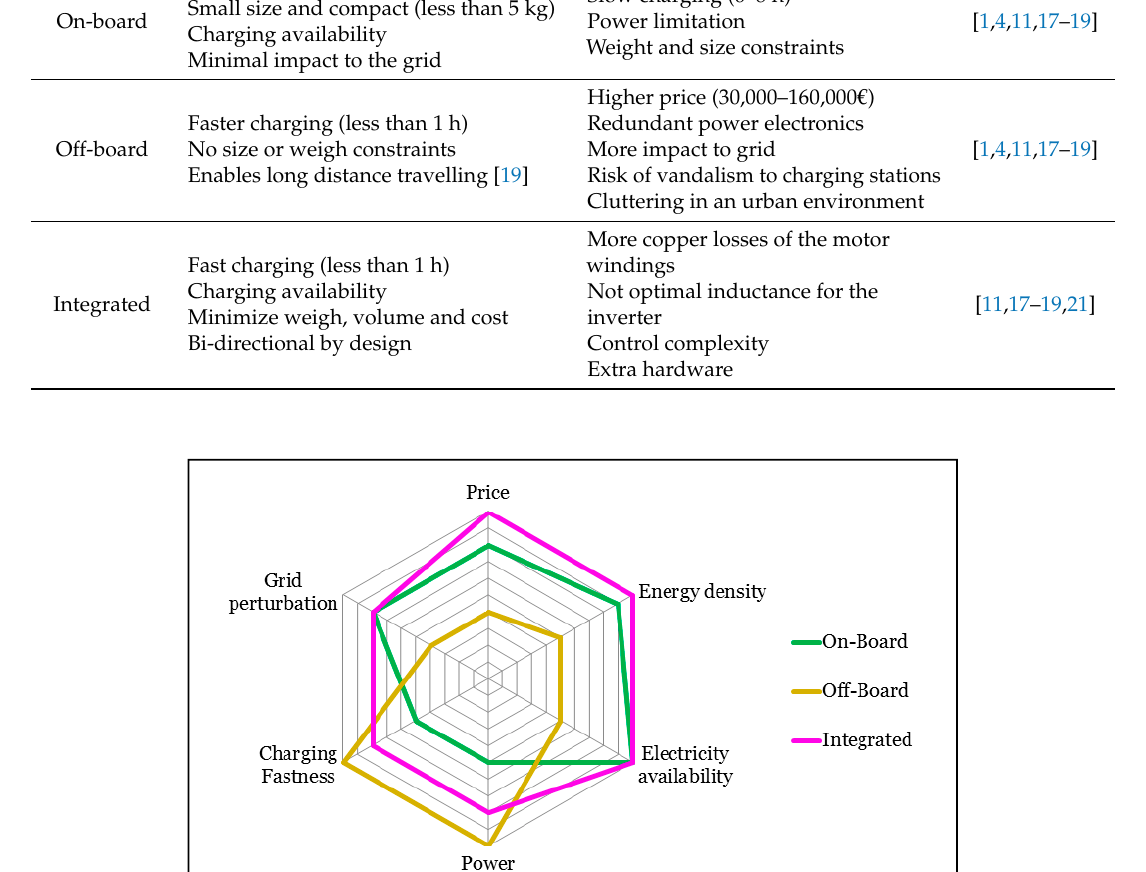
Table 2 . Comparison between On-Board, Off-Board and Integrated chargers.